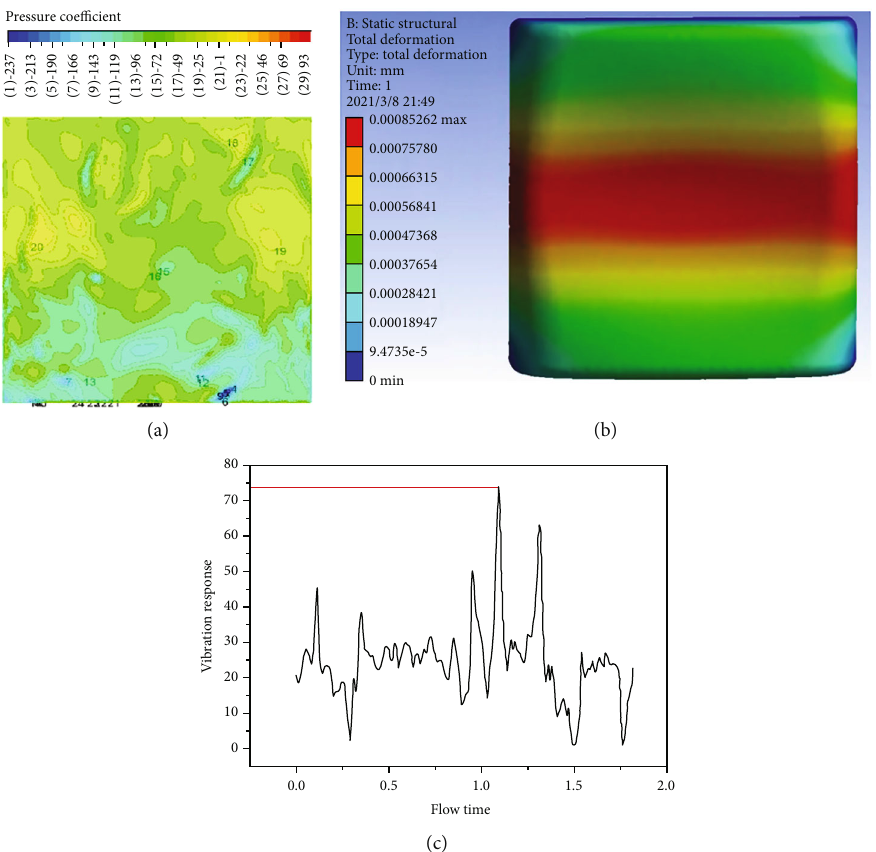
Figure 9: (a) Wind pressure distribution, blue indicates the minimum value and red indicates the maximum value. The gradient of color indicates di ff erent pressures. (b) Displacement diagram, the unit is mm. (c) Wind-induced response diagram, the red line indicates the maximum vibration response